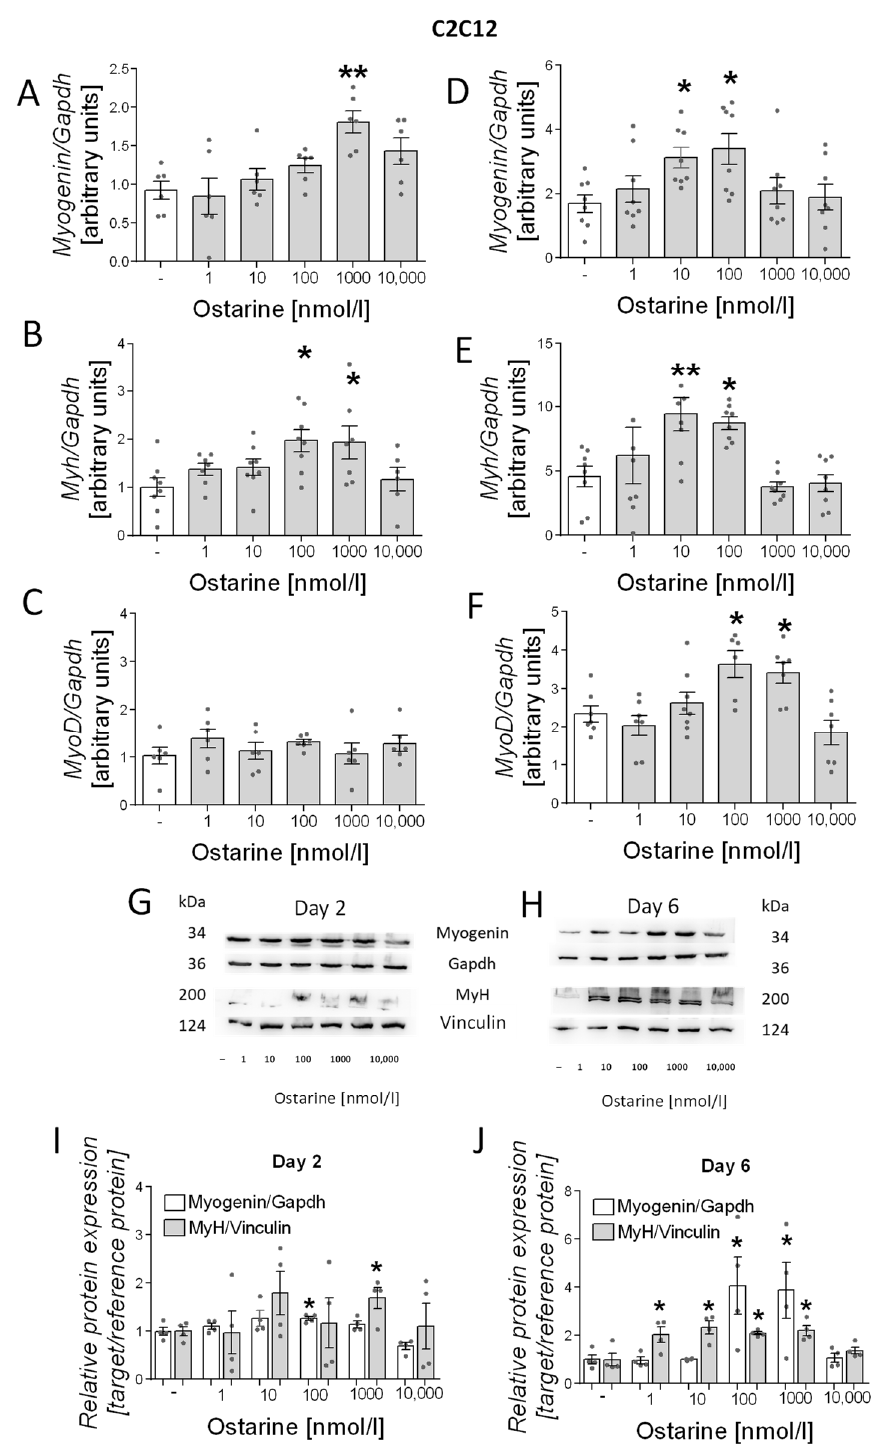
Figure 4. Effect of ostarine on C2C12 differentiation. mRNA expression of myogenin , myh , and myoD after ( A – C ) 2 days and ( D – F ) 6 days of differentiation initiation. ( G , H ) Effect ostarine on myogenin and MyH protein level changes after 2 and 6 days of differentiation initiation and quantification of the amount of proteins in day 2 and day 6 ( I , J ). Statistically significant differences are represented as * p < 0.05 and ** p < 0.01 versus corresponding control using one-way ANOVA followed by Dunnett’s post hoc test.